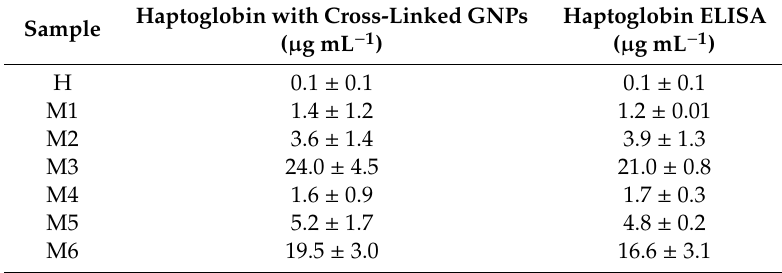
Table 2. Haptoglobin concentrations with and without cross-linked GNPs in milk samples using eCL factor with respect to bovine ELISA kit.